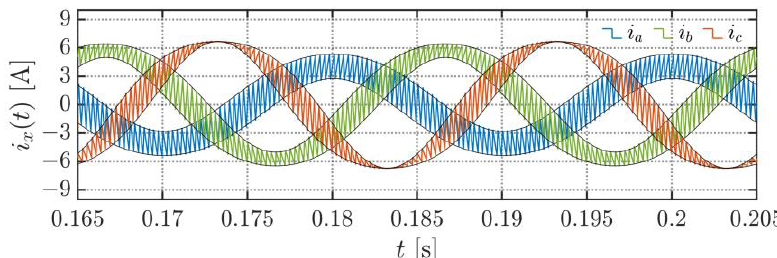
Figure 4. Phase currents with their current ripple envelopes (black lines) in case of modulation amplitude unbalance ( m a = 0.3, m b = 0.4, and m c = 0.5) at a switching frequency of 3.6 kHz.